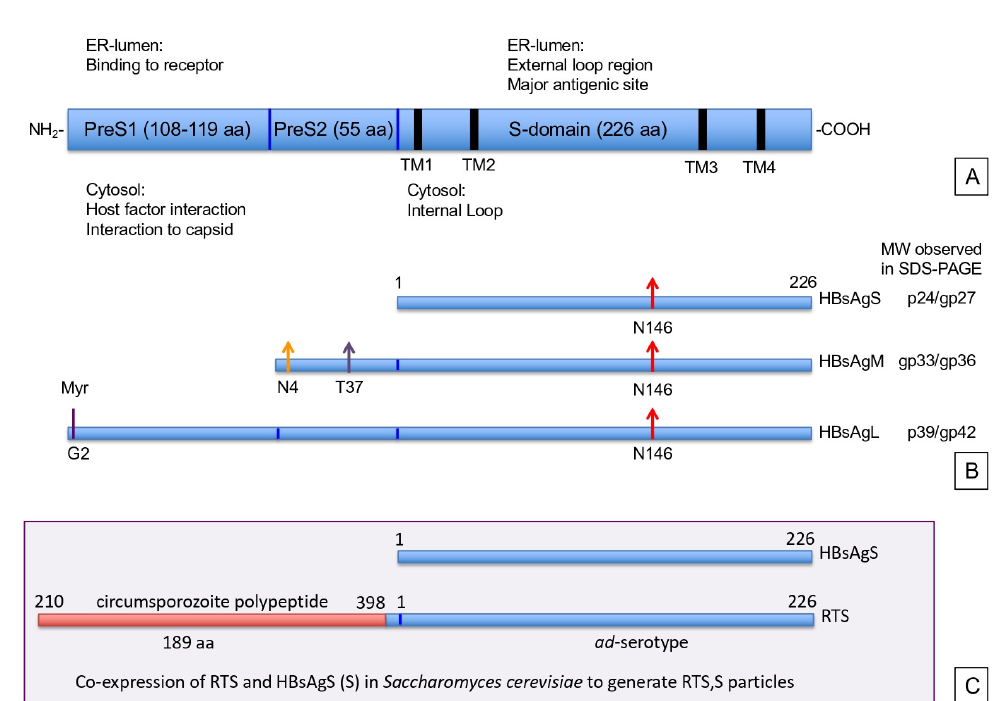
Figure 1. The surface (envelope) proteins (HBsAg) of hepatitis B virus (HBV): ( A ) The open reading frame encoding the complete hepatitis B surface antigen is depicted. The domain organization of preS1, preS2, and S, with the number of amino acids (aa) of the individual domains are specified. The four transmembrane regions (TM1–4) are indicated by the thick black lines. The function of the different domains in relation to their orientation towards the lumen of the endoplasmic reticulum (ER) or cytosol is indicated. ( B ) The individual HBsAg open reading frames for the small (HBsAgS), middle (HBsAgM), and large (HBsAgL) proteins, and their post-translational modifications are shown. The size of the HBsAgS protein is indicated by the number of amino acids. Arrows represent the utilized glycosylation sites. Red arrows mark asparagine 146 (N146) in the S-domain. Orange and purple arrows represent the N-4 and threonine 37 (T37) respectively, in the preS2 domain. The glycine residue at position 2 (G2) of the preS1 domain, indicated by a purple line, is myristolated. The observed molecular weights (MW) of the glycosylated (gp) and non-glycosylated proteins (p) separated under reducing conditions on a SDS-PAGE are indicated on the right. ( C ) Design of the RTS,S vaccine that is produced by co-expressing HBsAgS (aa 1–226) and the chimeric protein that is a fusion of the circumsporozoite polypeptide (210–398 aa) to the N-terminus of HBsAgS, including 4 aa from the preS2 domain.